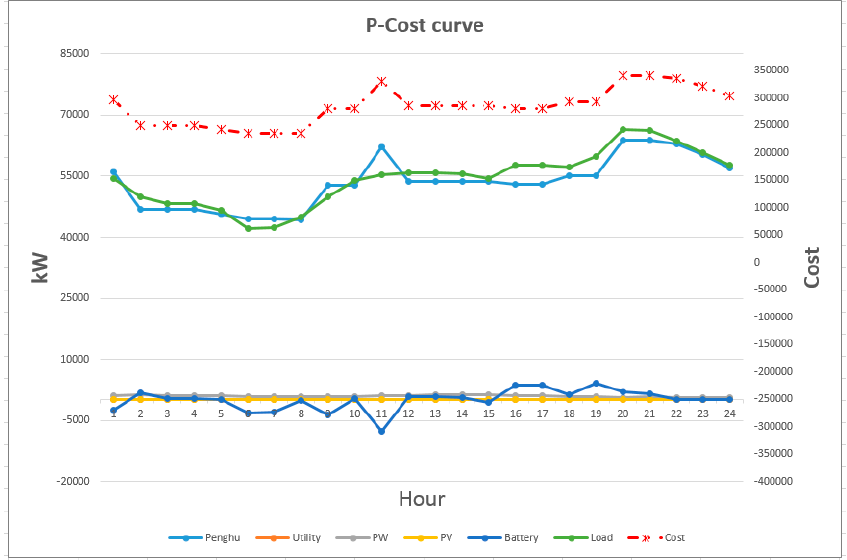
Figure 12. Generation supply scheme in the stand-alone scenario. Table 3. VAR at the various confidence